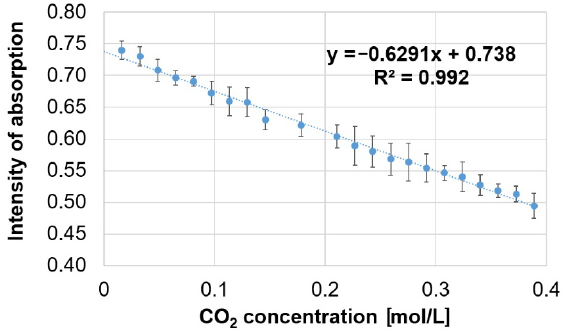
and the molar concentration of CO 2 gas in the sol. served, marking both the generation of protonated porphyrins and the link between CO 2 and the - NH from internal ring of porphyrins. Figure 5 represents the linear dependence